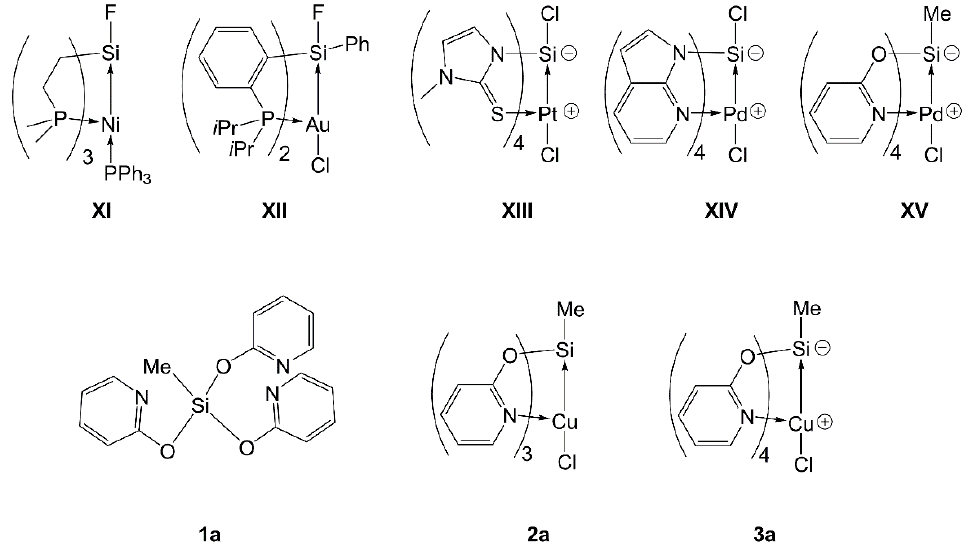
Figure 2. Selected examples of penta- and hexacoordinate Si compounds, which feature a TM atom as a formal lone pair donor in the Si coordination sphere ( XI − XV ) and compounds which serve as the starting point for the current study (compounds 1a – 3a ). For reasons of clarity of presentation, formal lone pair donation by L-type ligands (such as phosphanes) is indicated by a dative bond arrow, whereas X-type bonds (for example to alkyl groups) are indicated by a regular bond dash. Formal charges are included where necessary. Note: For the molecules which feature ambidentate buttressing ligands with both donor atoms involved in π -delocalized systems, further resonance forms may be drawn.